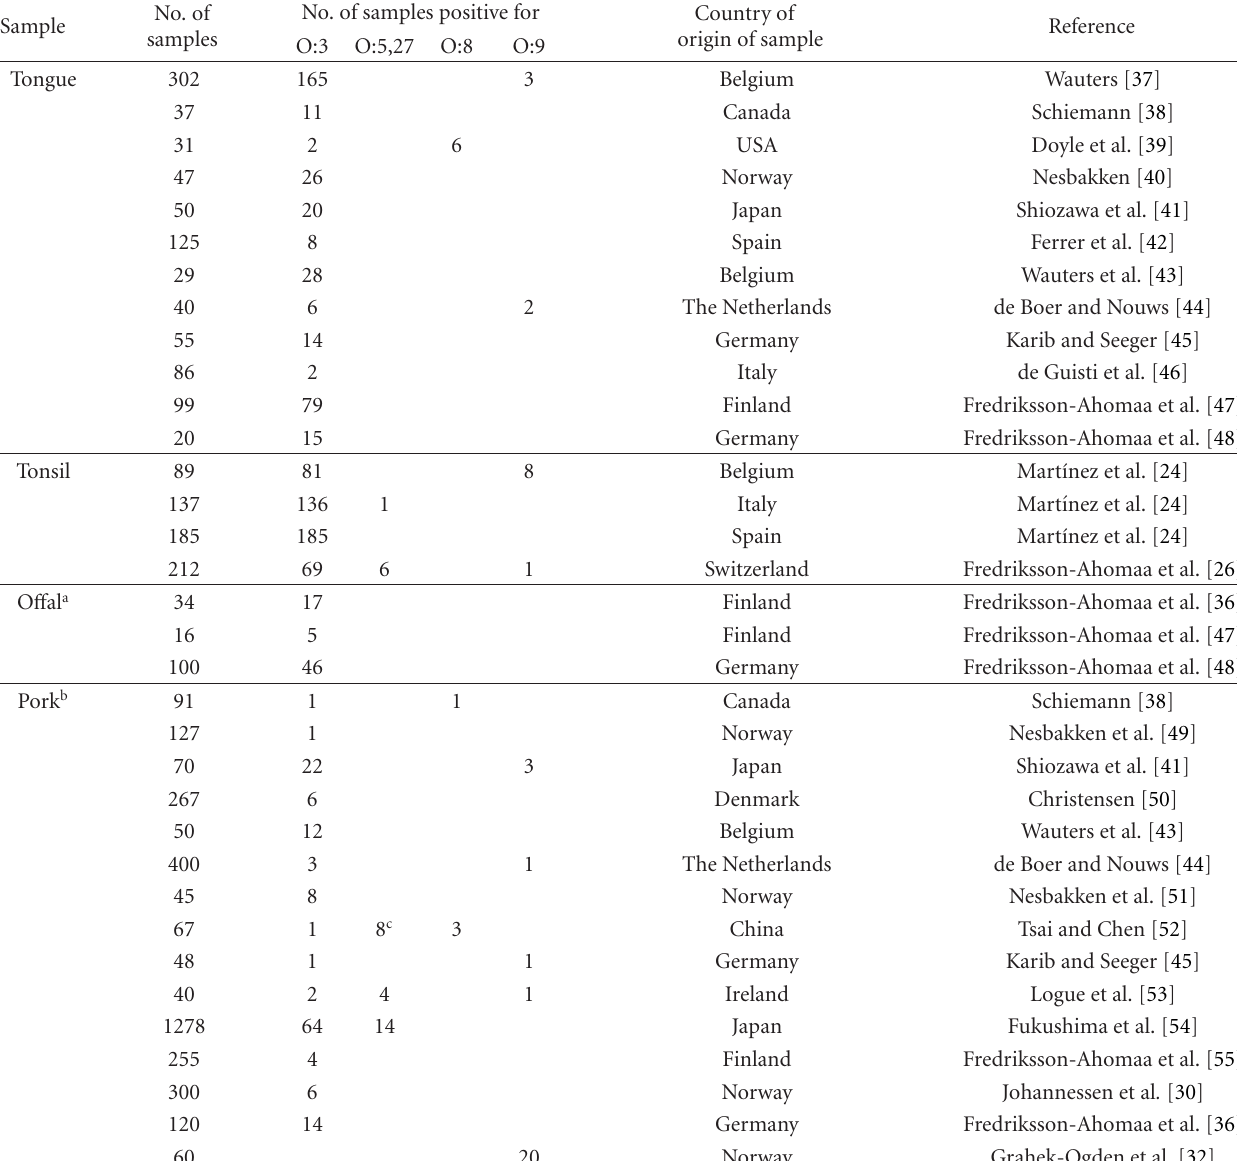
Table 2: Detection of pathogenic Y. enterocolitica in pork products by culture methods (partially adapted from Fredriksson-and Korkeala